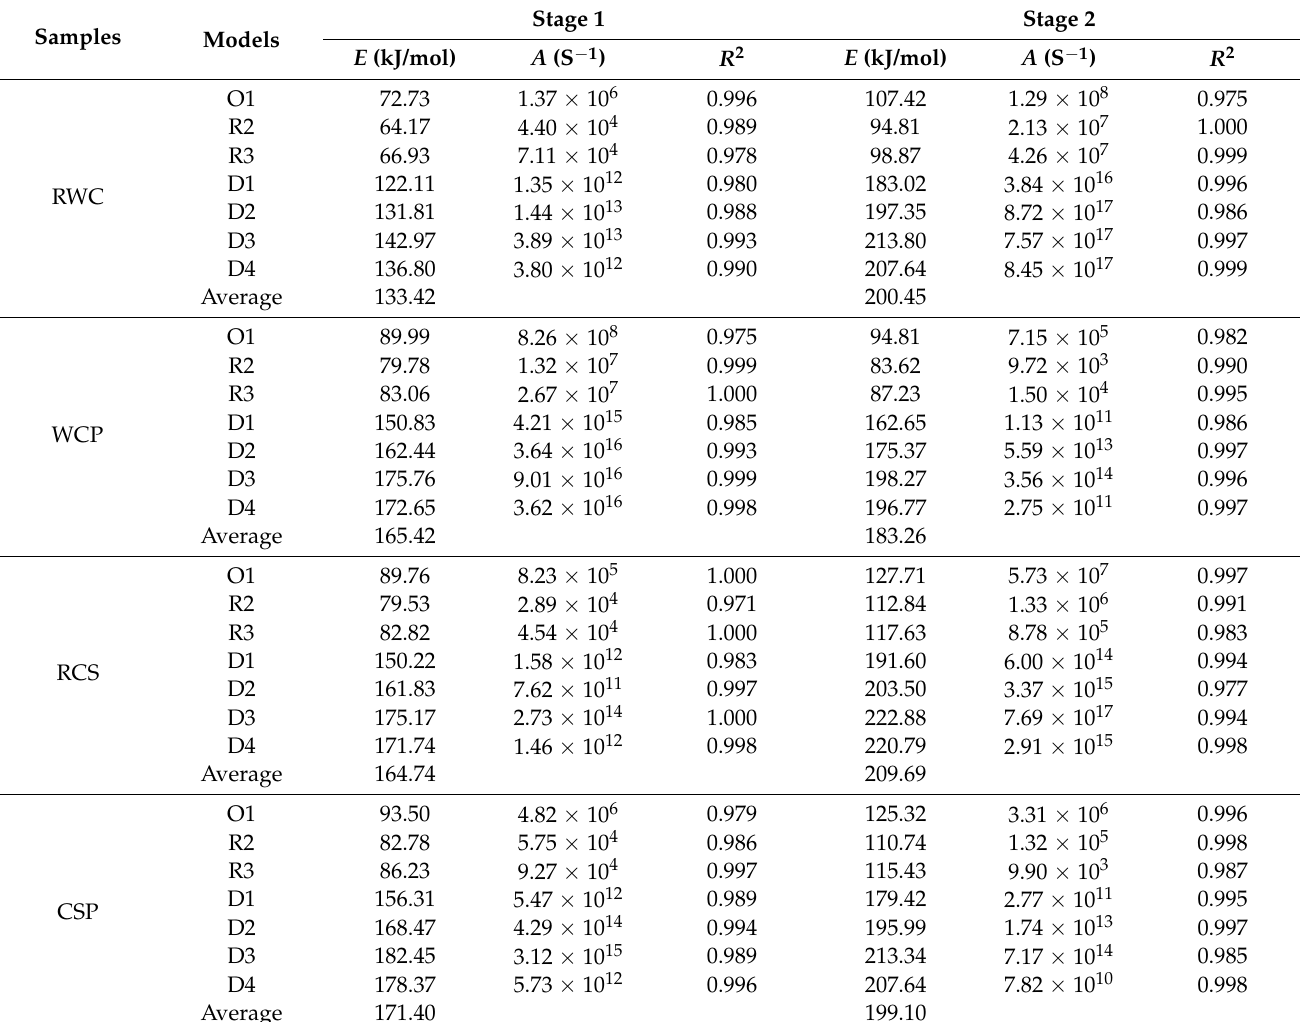
Table 4. Kinetic calculation results using the Coats–Redfern method from the TGA data of 10 ◦ C/min.